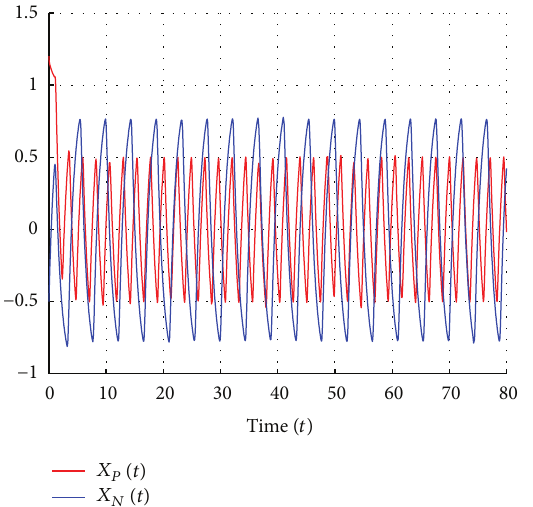
Figure 2: Transient behavior of the almost periodic solution of (31) located in 𝐵 ∗ .